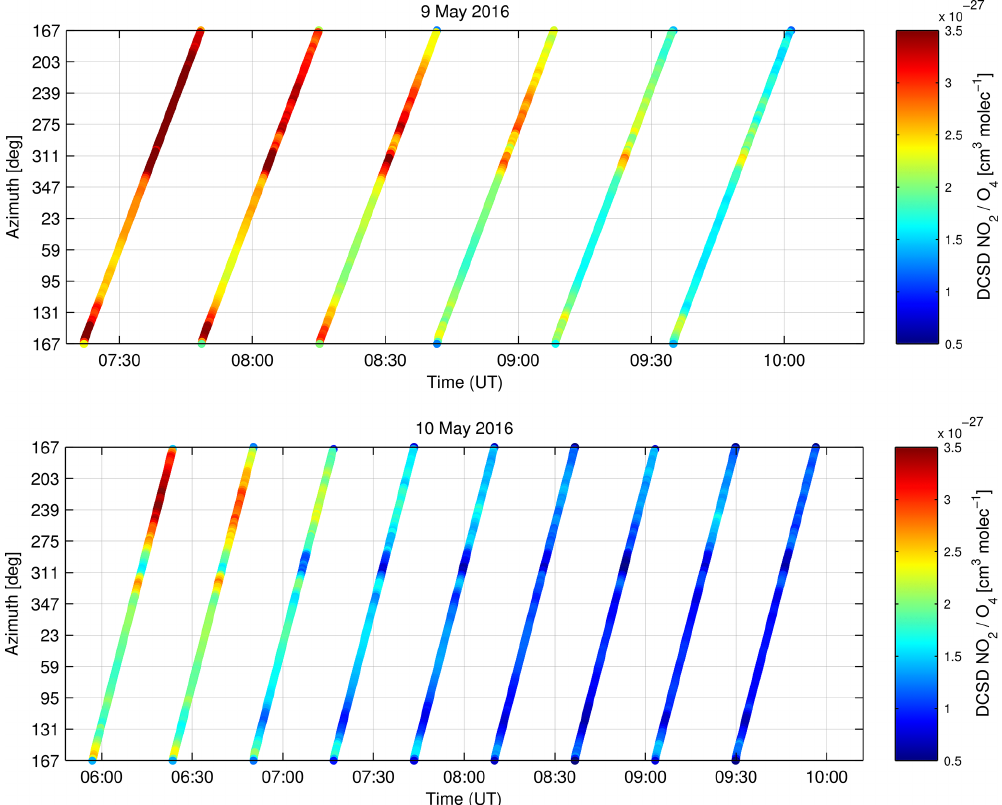
Figure 14. Spatial and temporal variability of DSCD NO 2 / O 4 obtained from tower DOAS off-axis measurements performed on 9 and 10 May